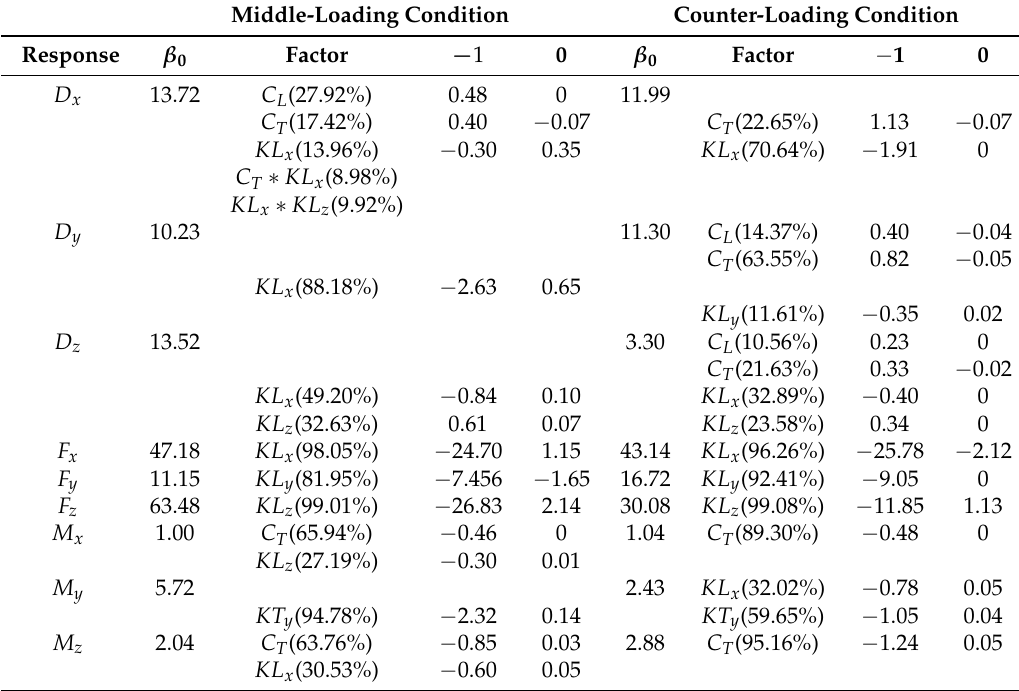
Table 5. Terms, percent contribution, and coefficients for each response variable and loading condition. Middle-Loading Condition Counter-Loading Condition